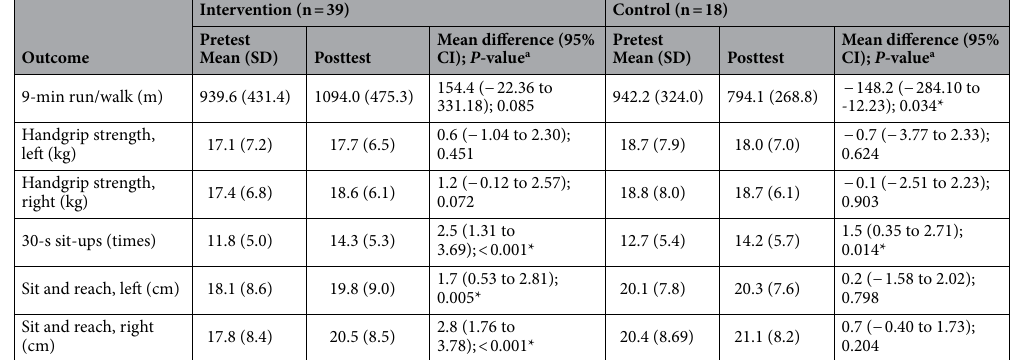
Table 2. Within-group changes in outcomes from the pretest to the posttest in the study groups. CI, Confidence interval. * p < 0.05. a Within-group difference was compared using paired sample t test.